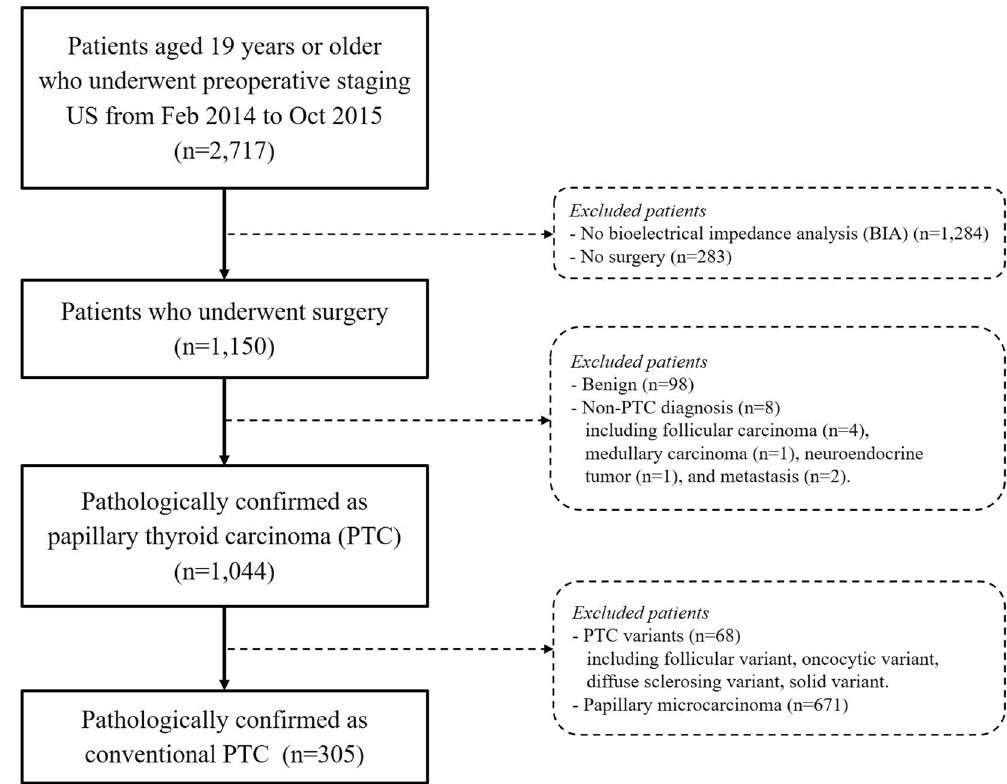
Figure 2. Patient selection diagram. A total of 2,717 patients were enrolled. Patients who did not undergo preoperative bioelectrical impedance analysis (BIA) or thyroid surgery were excluded. Only pathologic diagnosis of conventional PTC were included, resulting in a total of 305 patients eligible for final